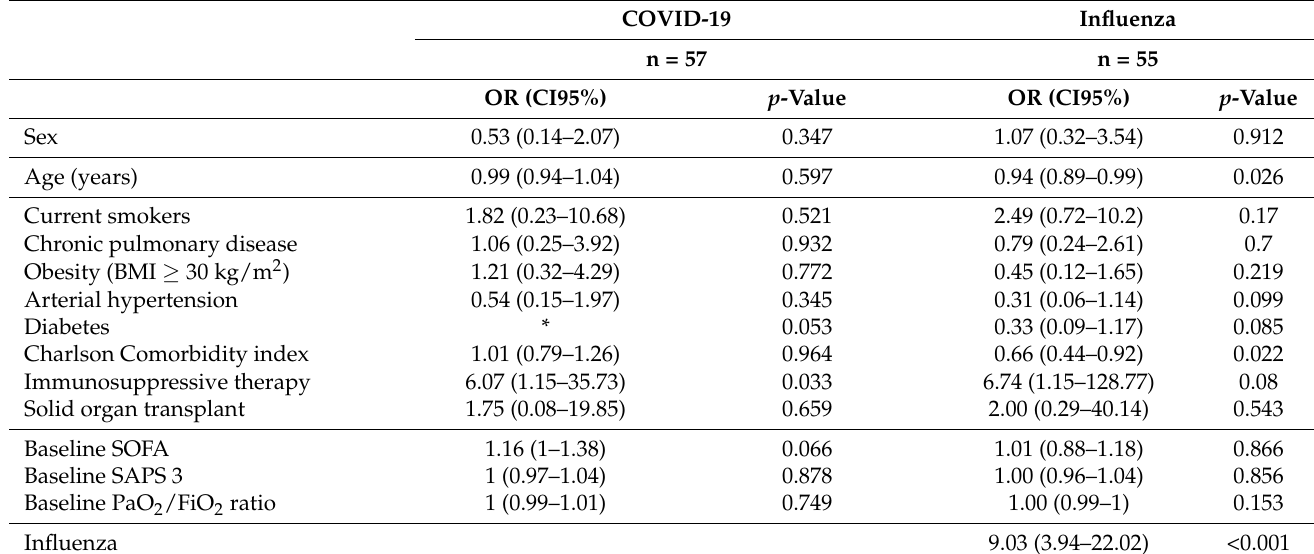
Table 3. Univariate analysis of the risk factors for co-infections.